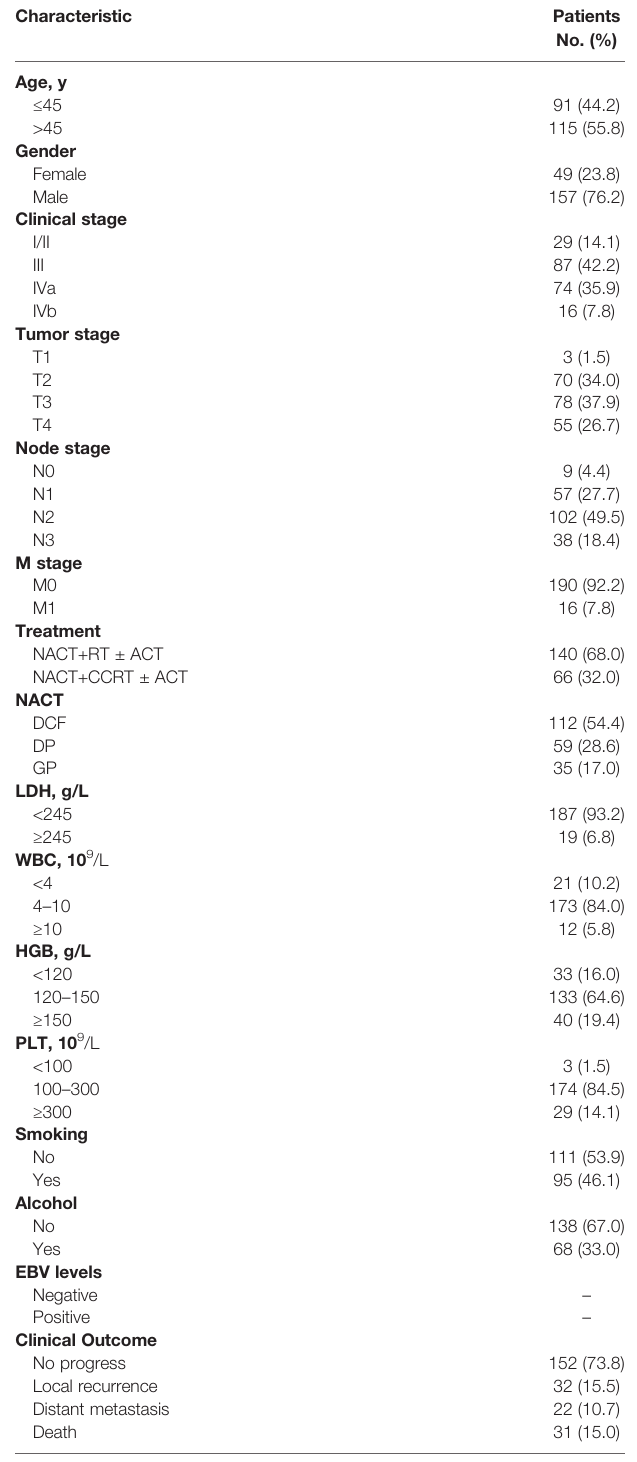
TABLE 1 | Patient demographic and clinical characteristics. Characteristic Patients